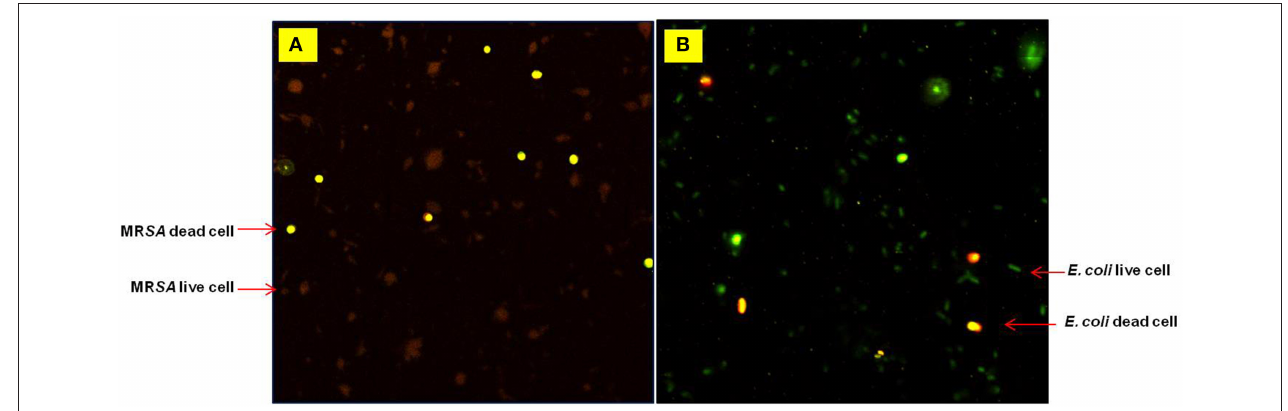
FIGURE 2 | Confocal microscopy images obtained during a Live/Dead cells assay for (A) MRSA-BAA at 6.25% and (B) E. coli at 12.5% (w/v) Agastache honey. Live cells (stained green) Dead cells (stained red).